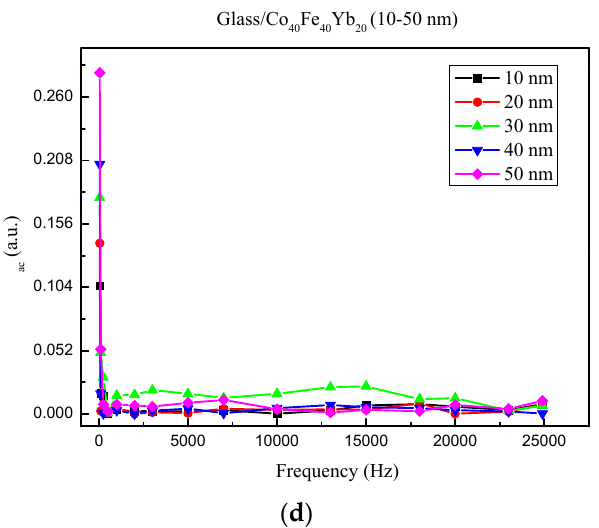
Figure 7. The relationship between the low-frequency alternate-current magnetic susceptibility ( χ ac ) and frequency. ( a ) as-deposited, ( b ) post-annealing at 100 °C, ( c ) post-annealing at 200 °C, ( d ) post-annealing at 300 °C.